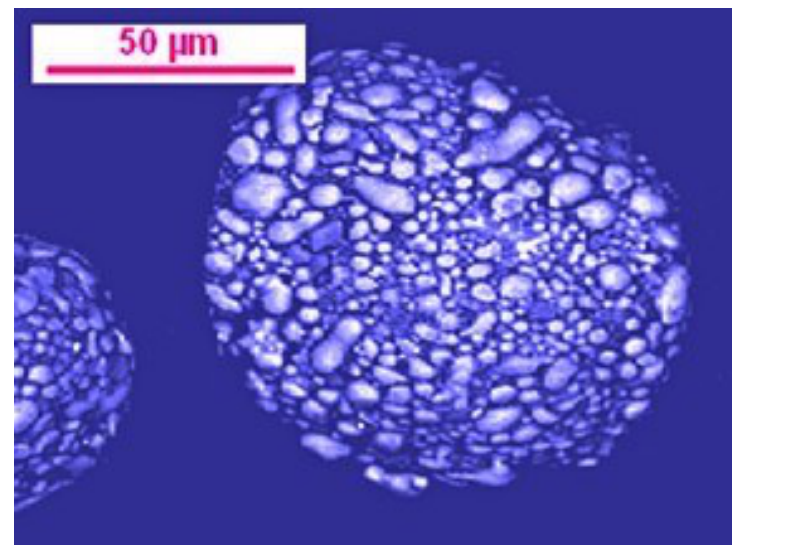
Figure 1 – (SEM) Scanning electron micrography of a Cu10wt.%Al powder particle Рис . 1 – (SEM) Электронная микрография частиц порошка Cu10 вес .%Al Slika 1 – Skening elektronska mikrografija (SEM) č estice praha